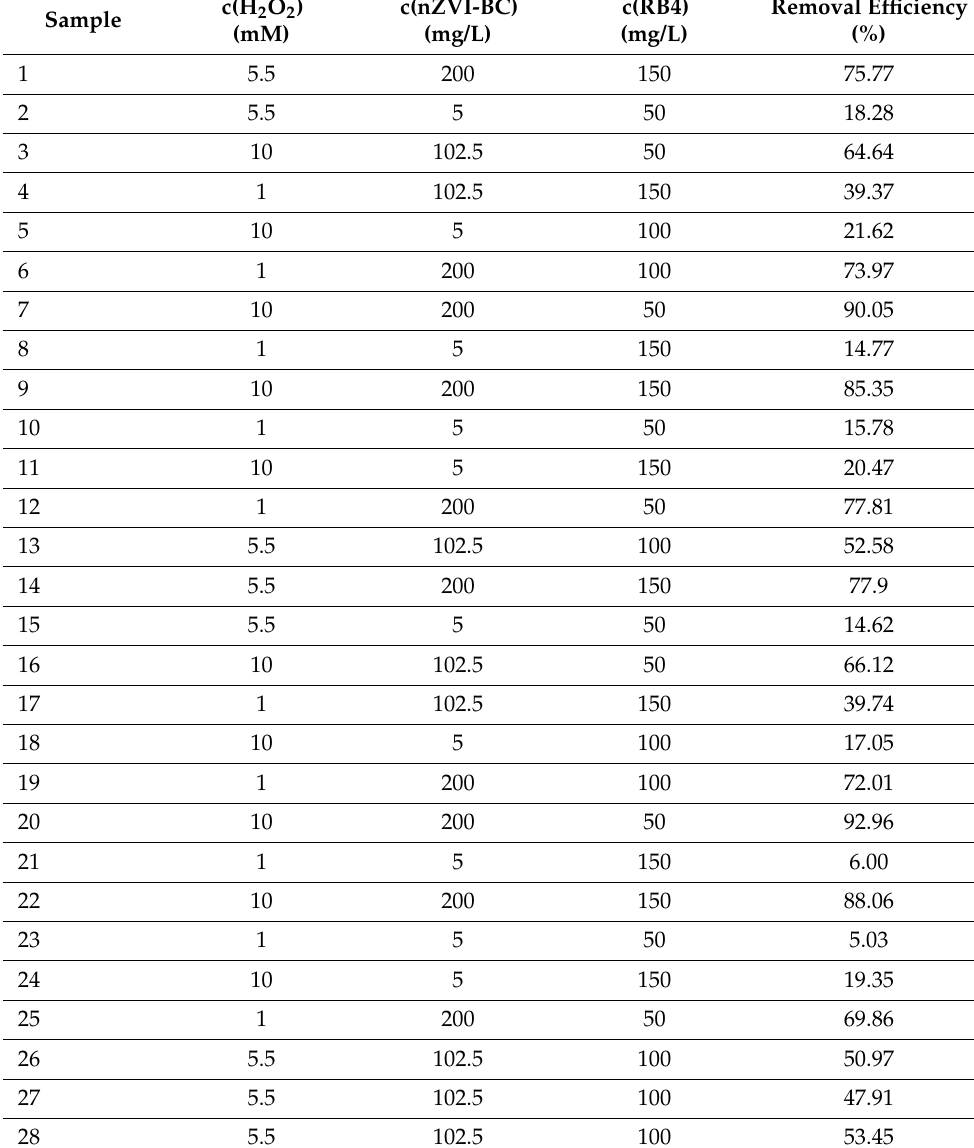
Table 2. Matrix of the experiment with the achieved decolorization efficiencies.